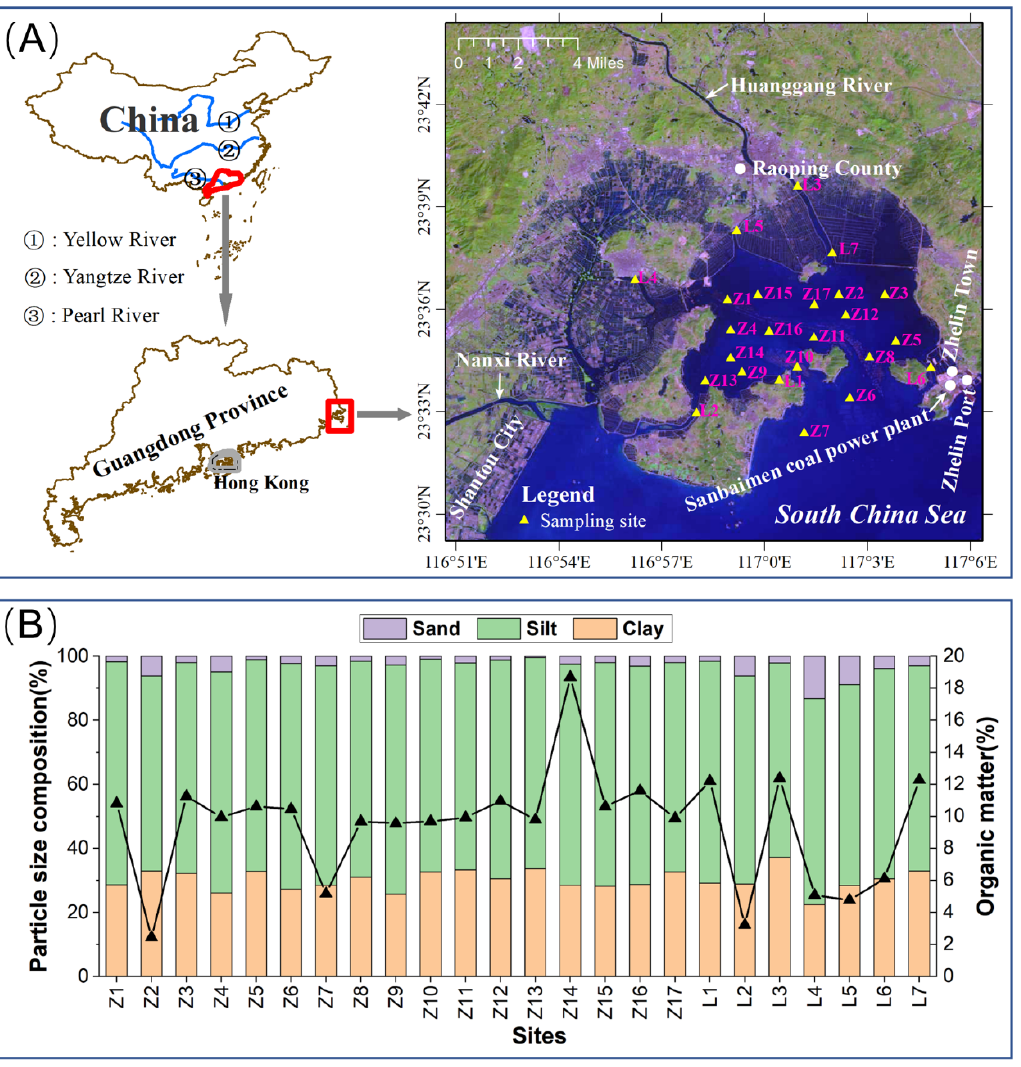
Figure 1. Map of the study area and sampling sites of Zhelin Bay, South China ( A ), as well as spatial variations of grain size compositions and organic matter in surface sediments of Zhelin Bay ( B ).